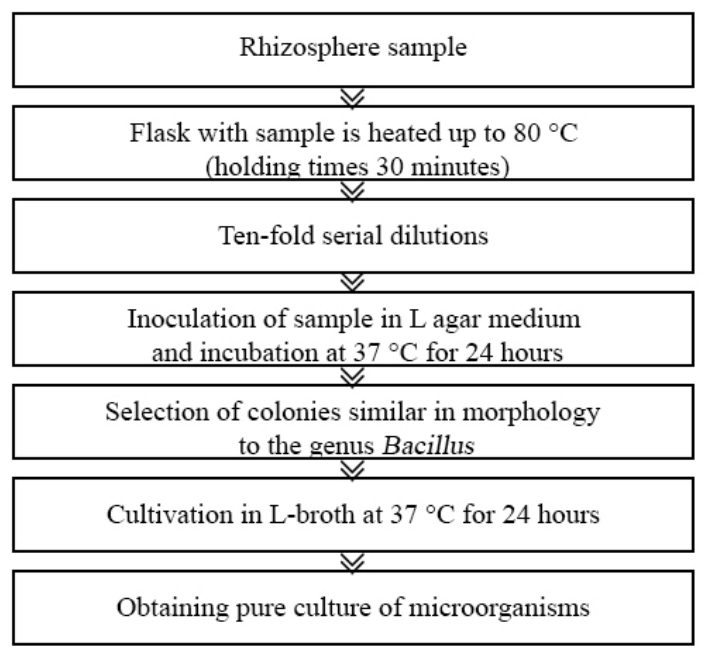
Figure 1. The isolation and identification scheme of rhizosphere